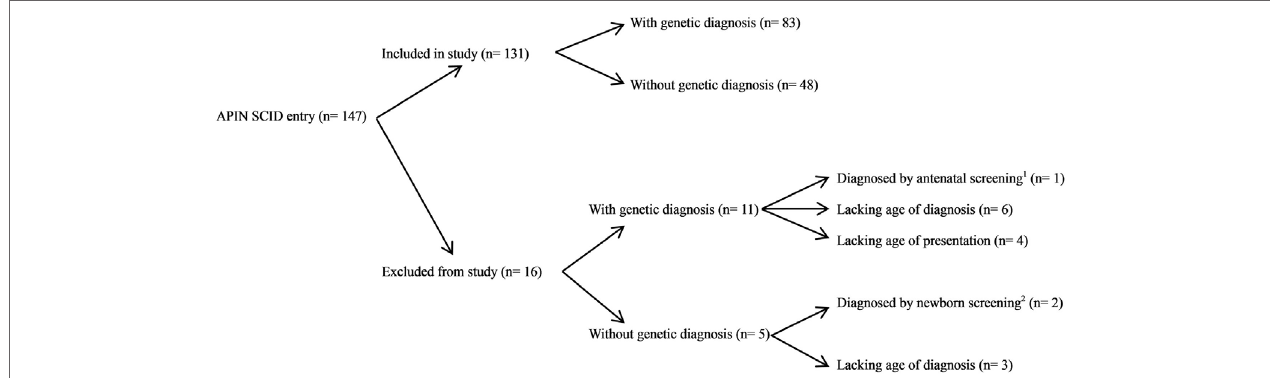
FigUre 2 | Patients selection algorithm in this study. From 147 SCID entries in the Asian Primary Immunodeficiency Network (APIN) database, 131 patients were included in our study and 16 patients were excluded from our study. Three patients were excluded as they were diagnosed by screening either antenatally or at birth. Thirteen patients were excluded due to the lack of age at presentation ( n = 4) or the lack of age at diagnosis ( n = 9). 1 Cordocentesis was performed due to positive family history of SCID, revealed low CD4 + count. 2 Complete blood count, lymphocyte subsets, and immunoglobulins measurement were performed in one patient due to positive family history, revealed severe T- and B-cell lymphopenia and low serum IgA and IgM; newborn T-cell receptor excision circle (TREC) screening revealed 0 TREC copy in another